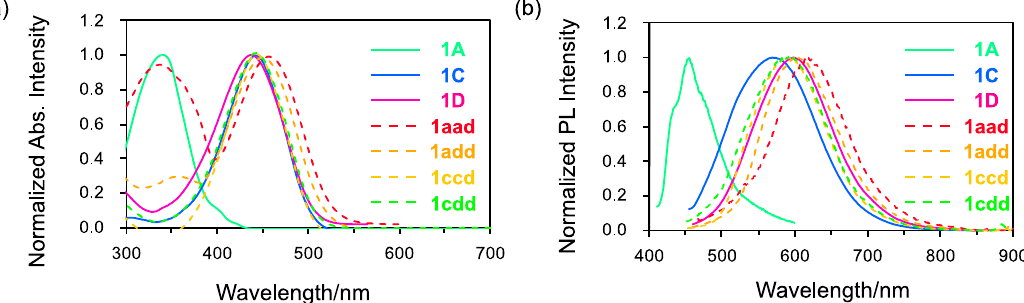
Figure 4. ( a ) Normalized absorption and ( b ) fluorescence spectra of 1A , 1C , 1D , 1aad , 1add , 1ccd , and 1cdd in toluene ( c = 1.0 × 10 − 5 M).